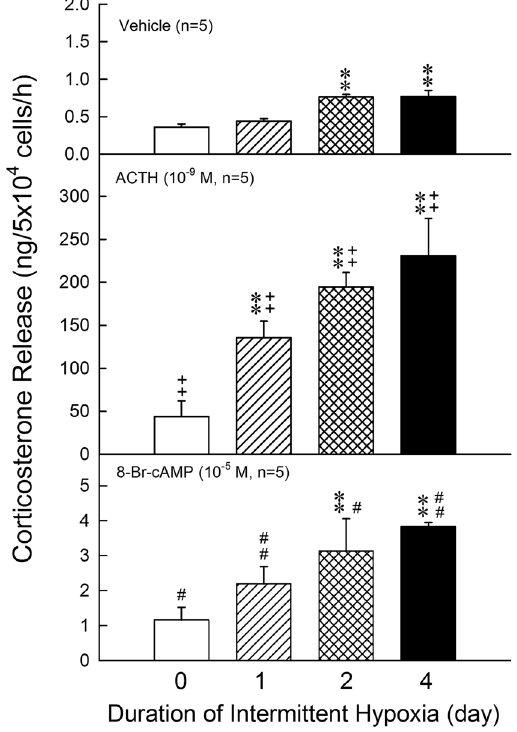
** P < 0.01 compared to normoxia (control) group. ++ P < 0.01 compared to control group. # P < 0.05, ## P < 0.01 compared to control group by Student’s t -test. Each value represents the mean ± SEM.